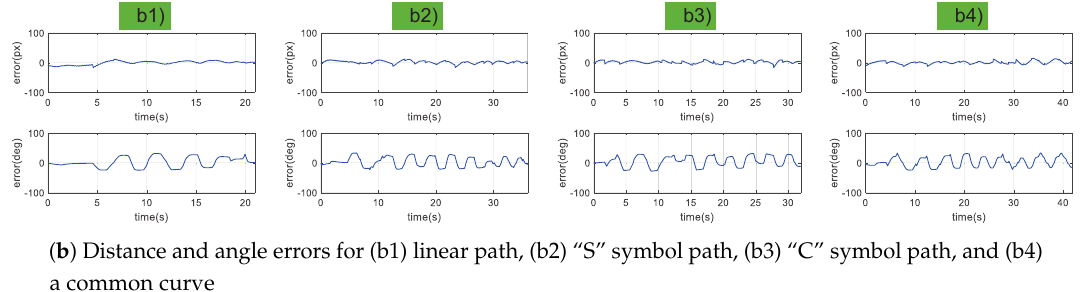
Figure 10. Results of 2D path following are shown in figure ( a ). The respective distance and steering angle errors are shown in figure ( b ). The reference path is denoted by a navy blue line and the real-time path is denoted by light blue.